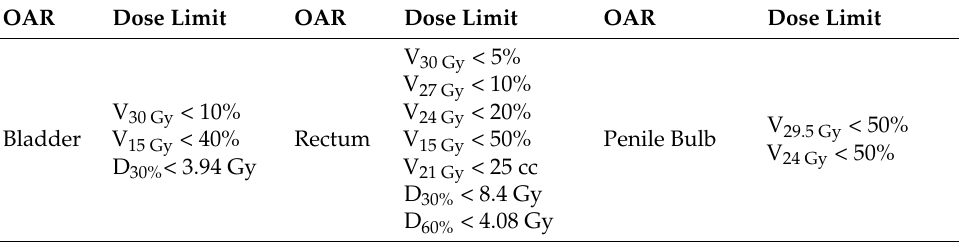
Table 2. OARs and